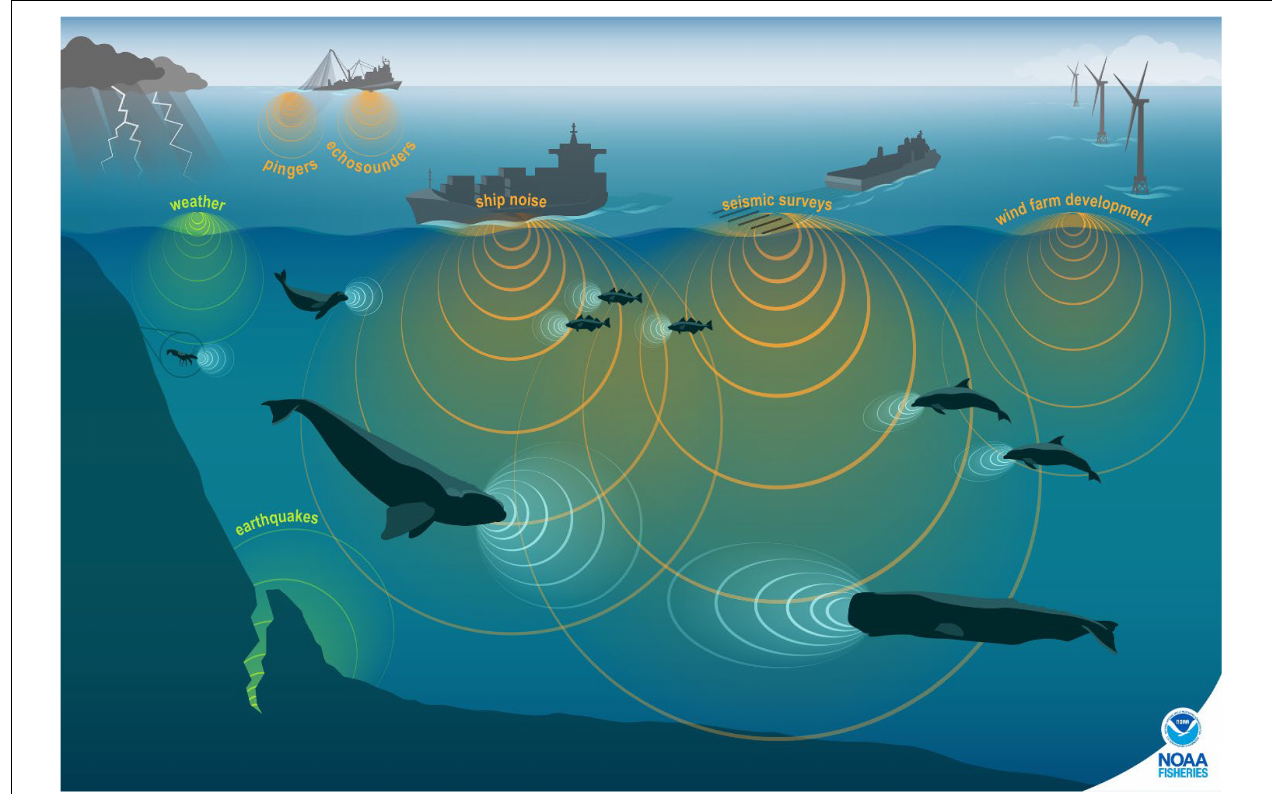
FIGURE 2 | This conceptual illustration shows images of anthropogenic (human-created), biological (marine animal), and abiotic (environmental) sources of sound and approximately proportional sound waves, making up an ocean soundscape. The sound sources include weather, earthquakes, snapping shrimp, harbor seal, Atlantic cod, right whale, sperm whale, common dolphins, fishing vessel, shipping vessel, seismic survey ship, and wind farm development. The sound waves are represented by overlapping colored circles that indicate the type of sounds: human-made sounds are orange, animal sounds are light blue, and environmental sounds are light green. The circles increase in size to show the approximate magnitude of sound waves and distances noise travels